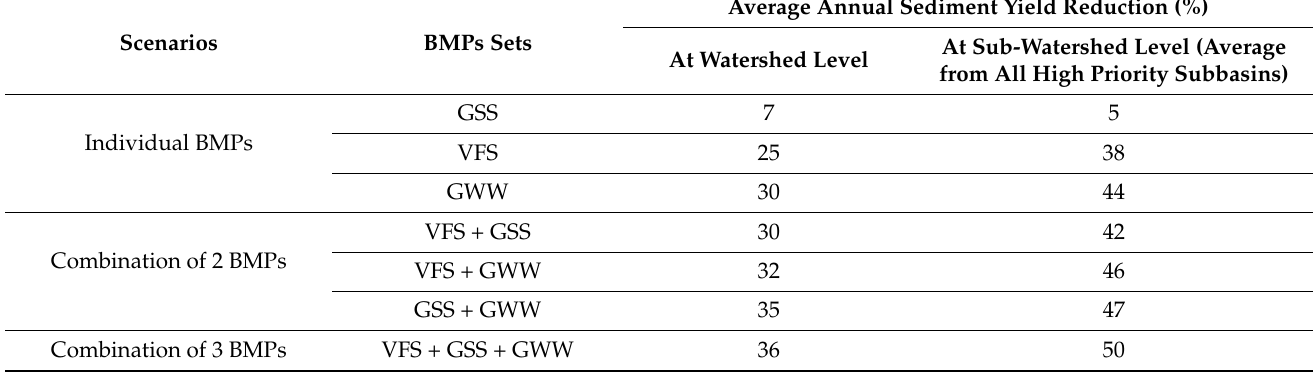
Table 7. Effects of BMPs on sediment yield reduction at watershed and sub-watershed